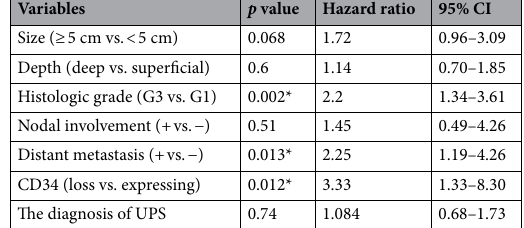
Table 4. Multivariate analysis of factors with potential to affect overall survival. * p < 0.05.